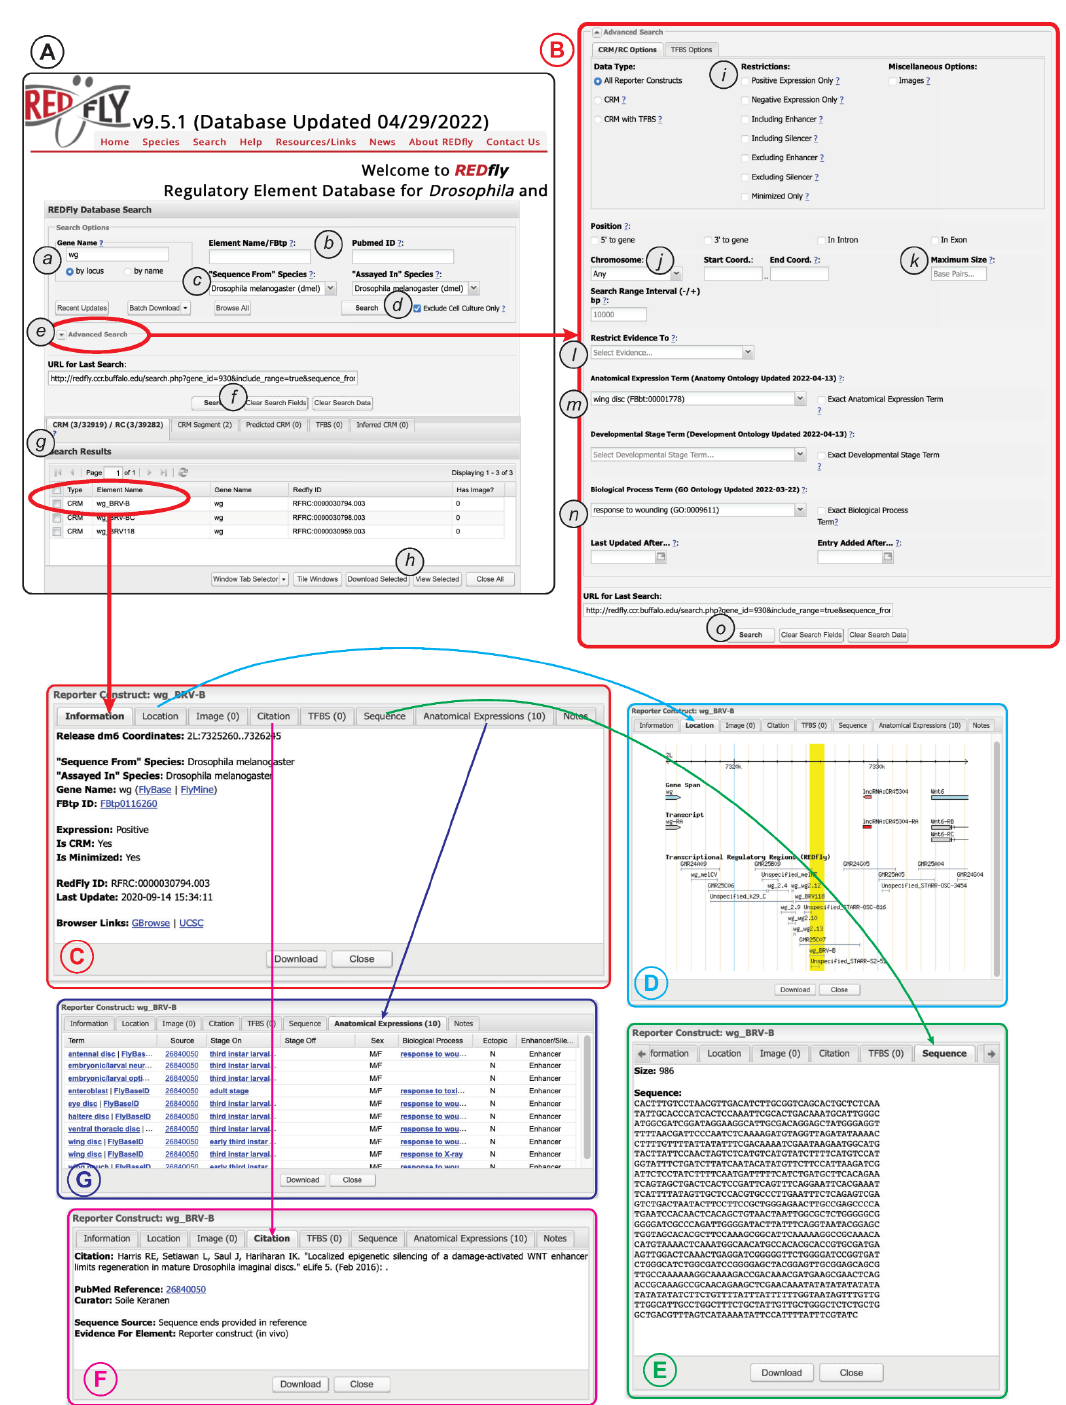
Figure 4. The REDfly search interface. See text for details. ( A ) The basic search panel. ( B ) The Advanced Search panel. ( C ) The Detailed Results “Information” pane. ( D ) The Detailed Results “Location” pane. ( E ) The Detailed Results “Sequence” pane. ( F ) The Detailed Results “Citation” pane. ( G ) The Detailed Results “Anatomical Expression”